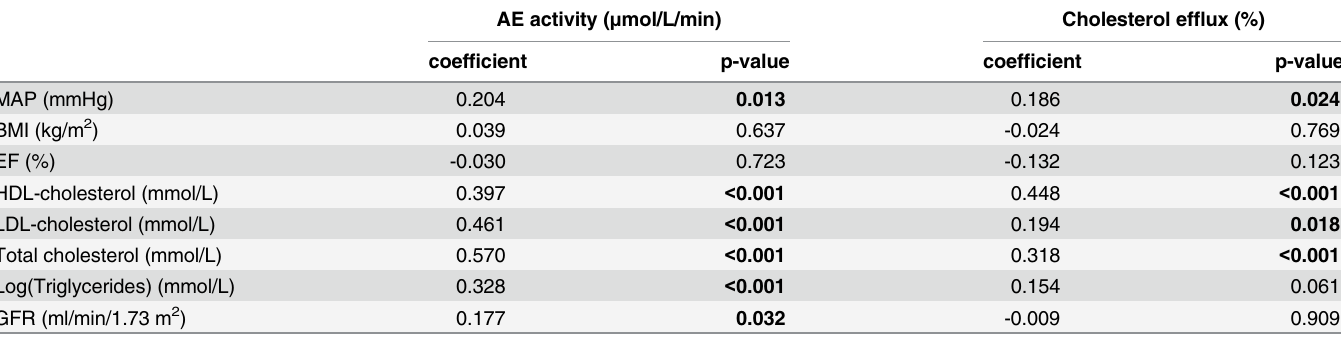
Table 2. Pearson correlation of clinical and laboratory variables with HDL AE activity and cholesterol efflux